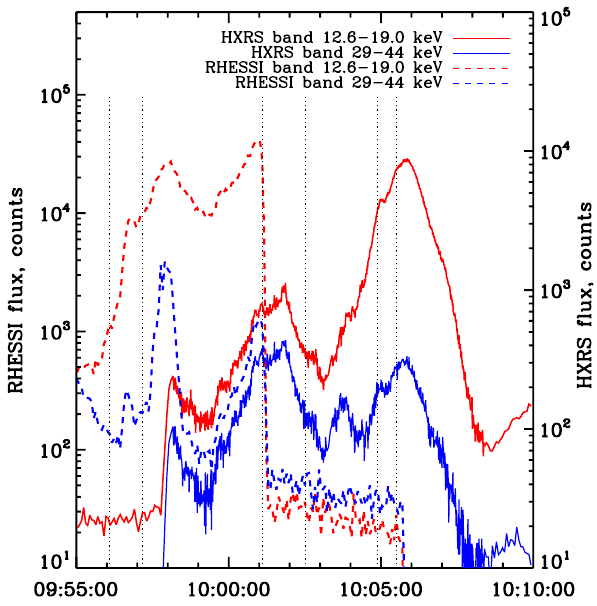
Fig. 1. Temporal evolution of the hard X-ray flux obtained by RHESSI and HXRS. The RHESSI data were transformed to HXRS energy bands. Edges of the three intervals covered by the MFS ob- servations are marked by vertical dotted